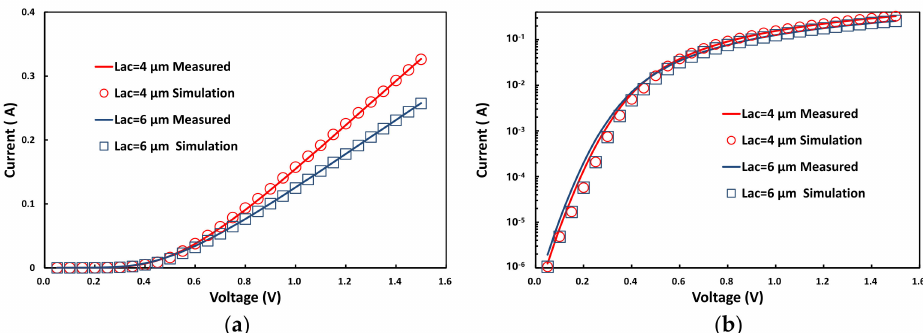
Figure 4. ( a ) Static current-voltage characteristics in linear coordinates. ( b ) Static current-voltage characteristics in logarith- mic